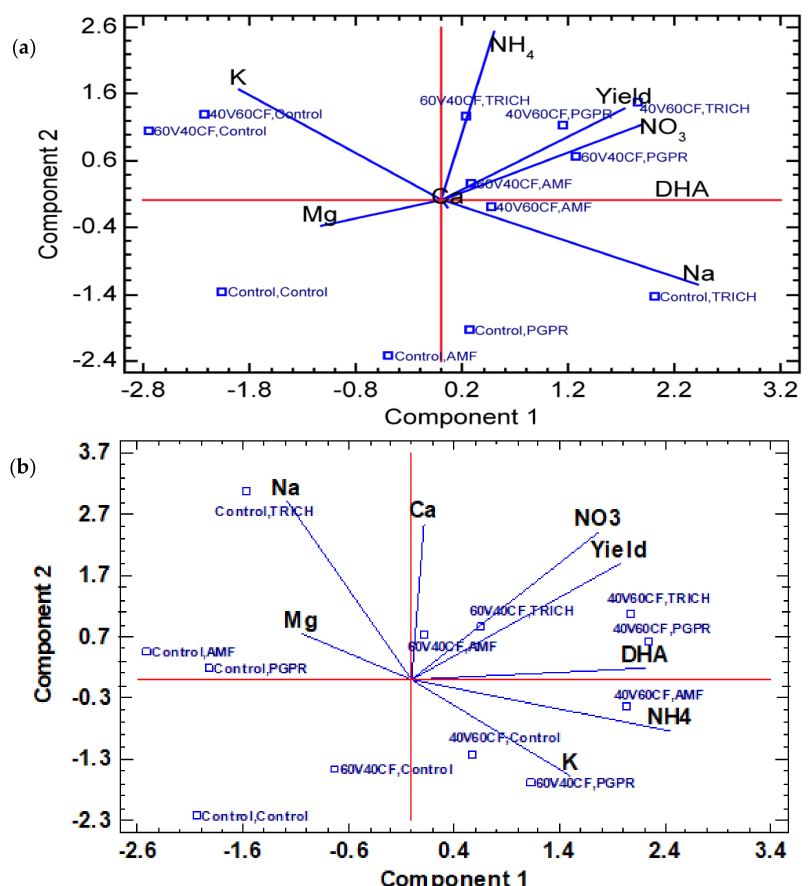
Figure 2. Principal component analysis bi-plot of component weights between the main cations and anions. ( a ) Sap and yield of the melon crop according to substrates and PGPMs treatments. First component (31.64% variance), second component (24.12% variance). Substrate treatments (% v / v ): vermicompost (V) and coconut fiber (CF) (20V80CF (control), 40V60CF and 60V40CF as indicated. PGPMs treatments were AMF (arbuscular mycorrhiza fungi), PGPR (plant-growth-promoting rhi- zobacteria), TRICH ( Trichoderma asperellum + Trichoderma atroviride ), and control (no PGPMs), as indicated. ( b ). Sap and yield of the tomato crop according to the substrates and PGPM treatments. First component (37.31% variance), second component (27.38% variance). Substrate treatments (% v / v ) vermicompost (V) and coconut fiber (CF): 20V80CF (control), 40V60CF and 60V40CF. PGPMs treatments were AMF (arbuscular mycorrhiza fungi), PGPR (plant-growth-promoting rhizobacteria), TRICH ( Trichoderma asperellum + Trichoderma atroviride ), and control (no PGPM), as